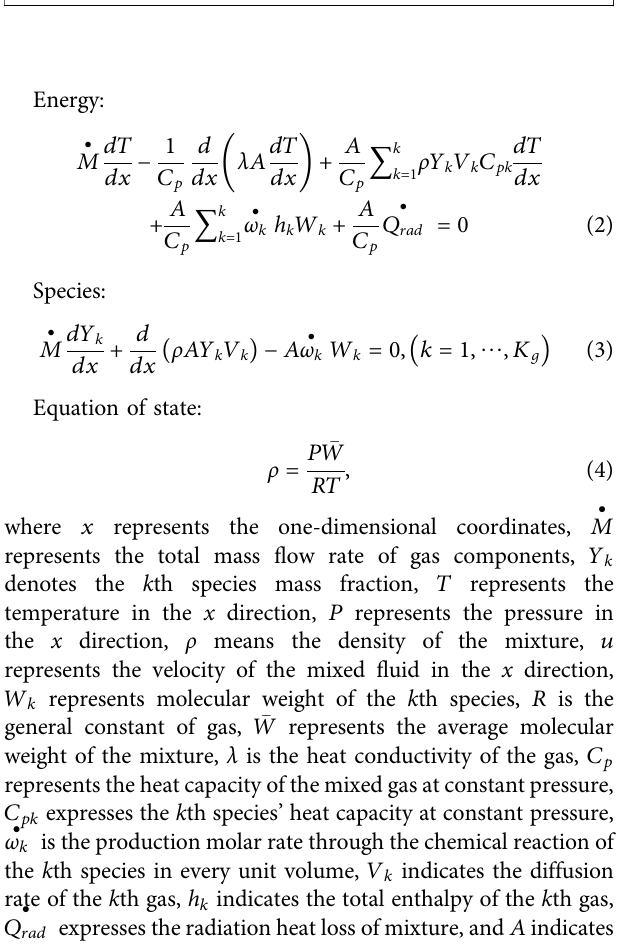
FIGURE 3 | One-dimensional laminar fl ame grid